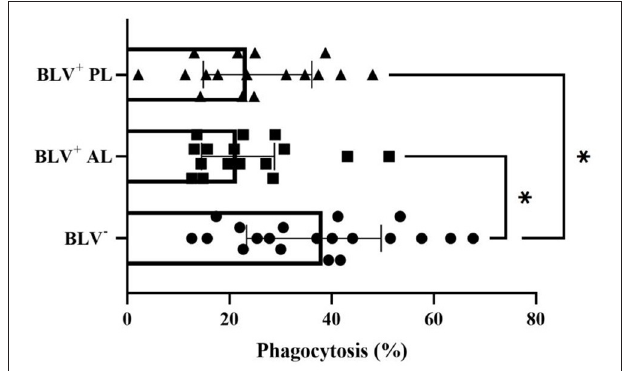
FIGURE 1 | Percentage (individual values and median ± interquartile range) of milk macrophages that phagocytized S. aureus from health mammary glands in bovine leukemia virus (BLV) seronegative (BLV − ) and in BLV-infected (BLV + ) dairy cows without (AL) and with persistent lymphocytosis (PL). * P < 0.05.